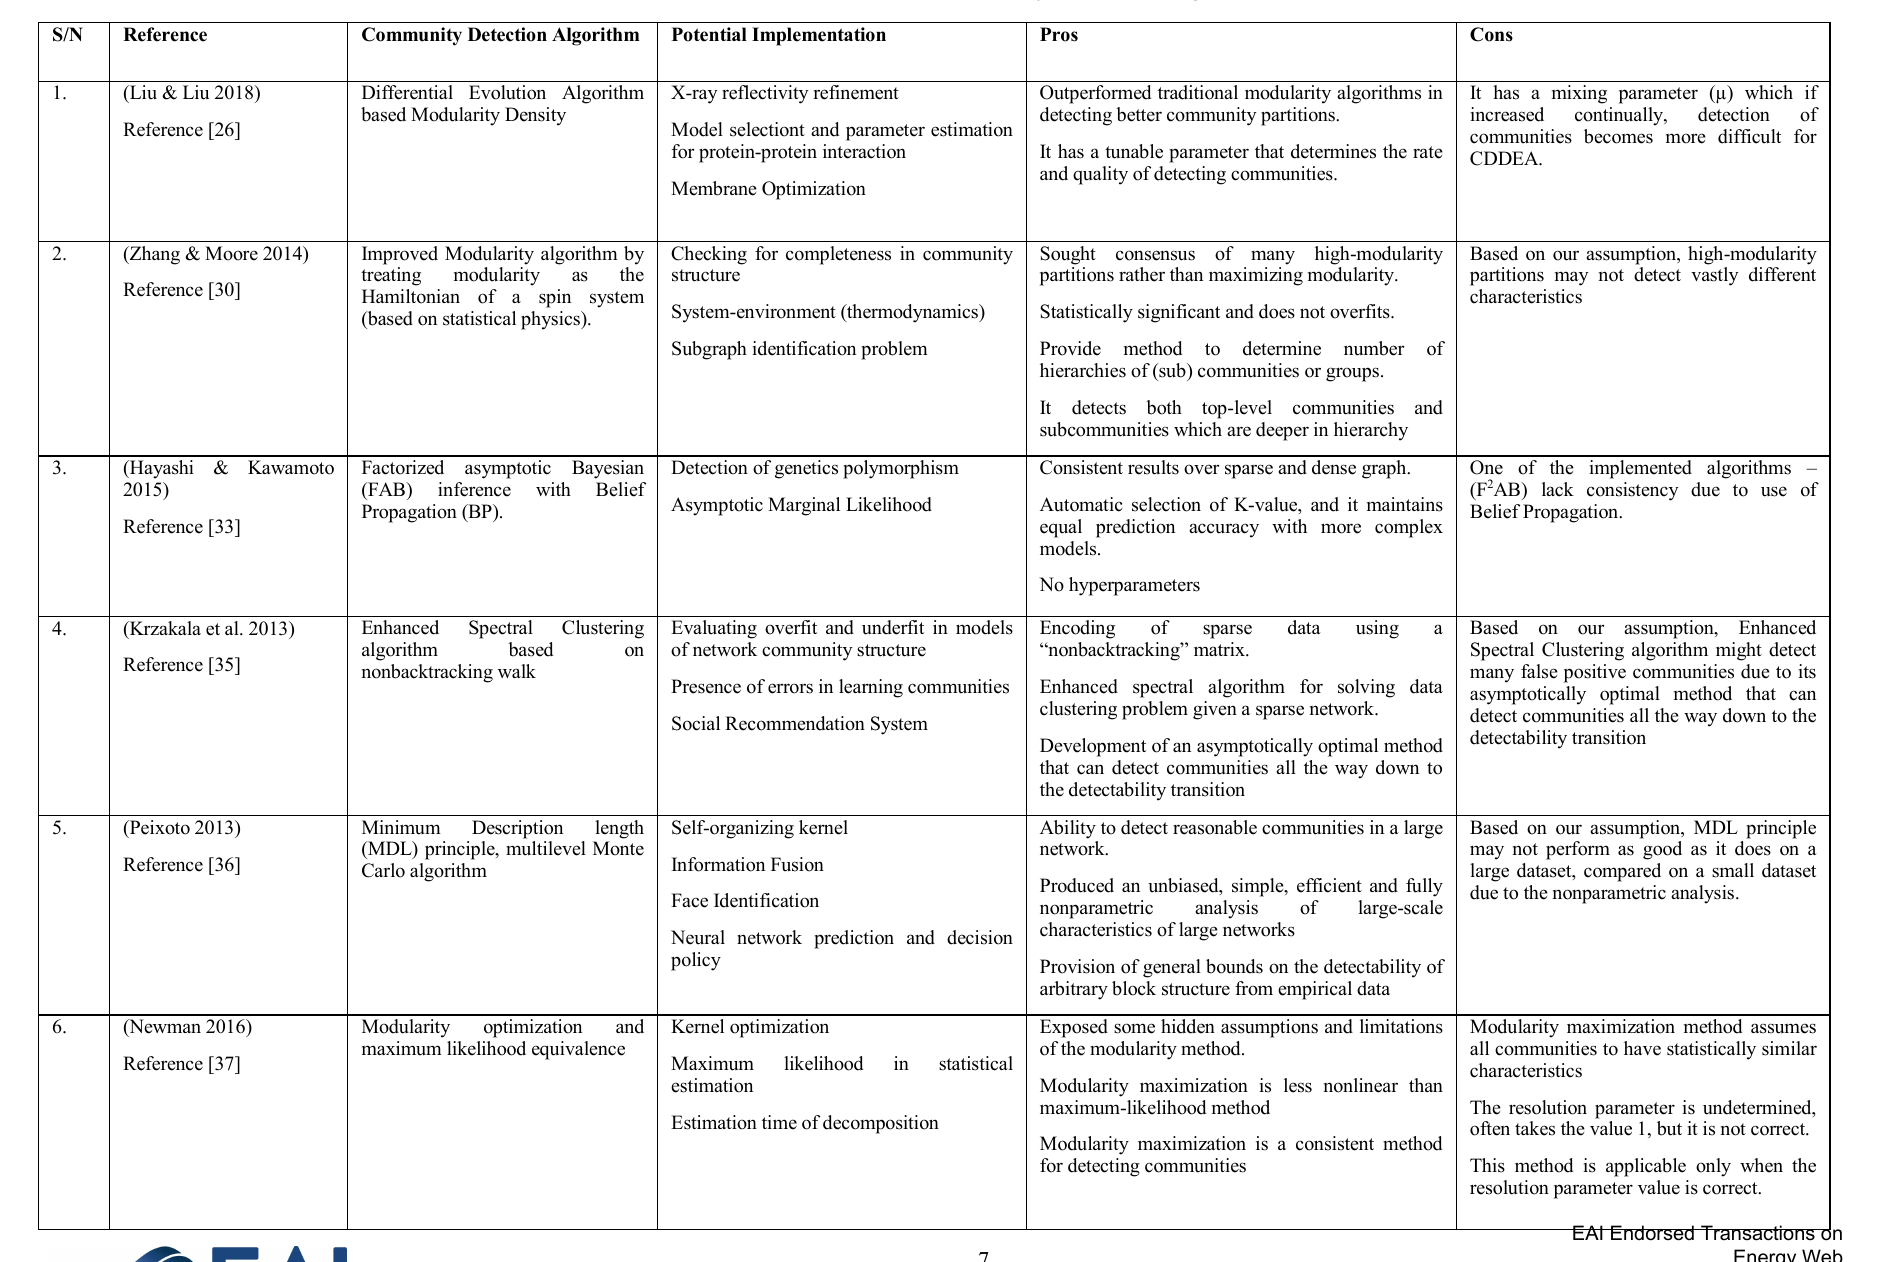
Table 1. Popular Community Detection